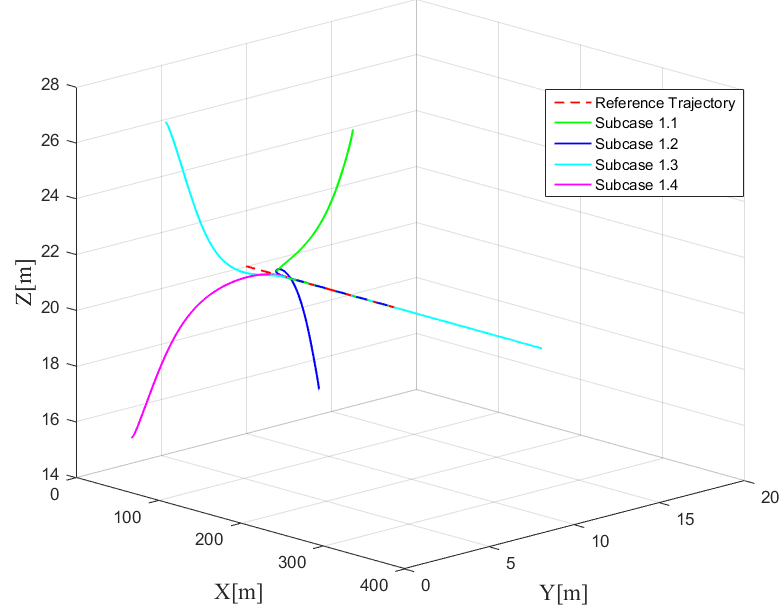
Figure 3. 3D trajectory tracking performance of Case 1.